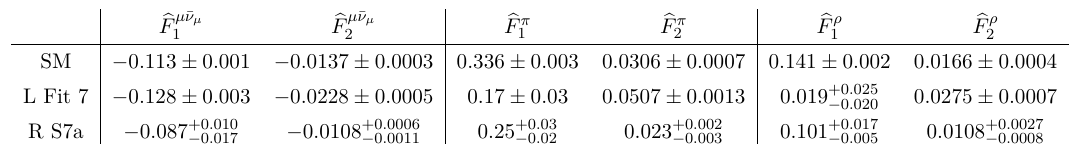
Table 1 . Semileptonic decay widths Γ τ = Γ (Λ b → Λ c τ ¯ ν τ ) and Γ